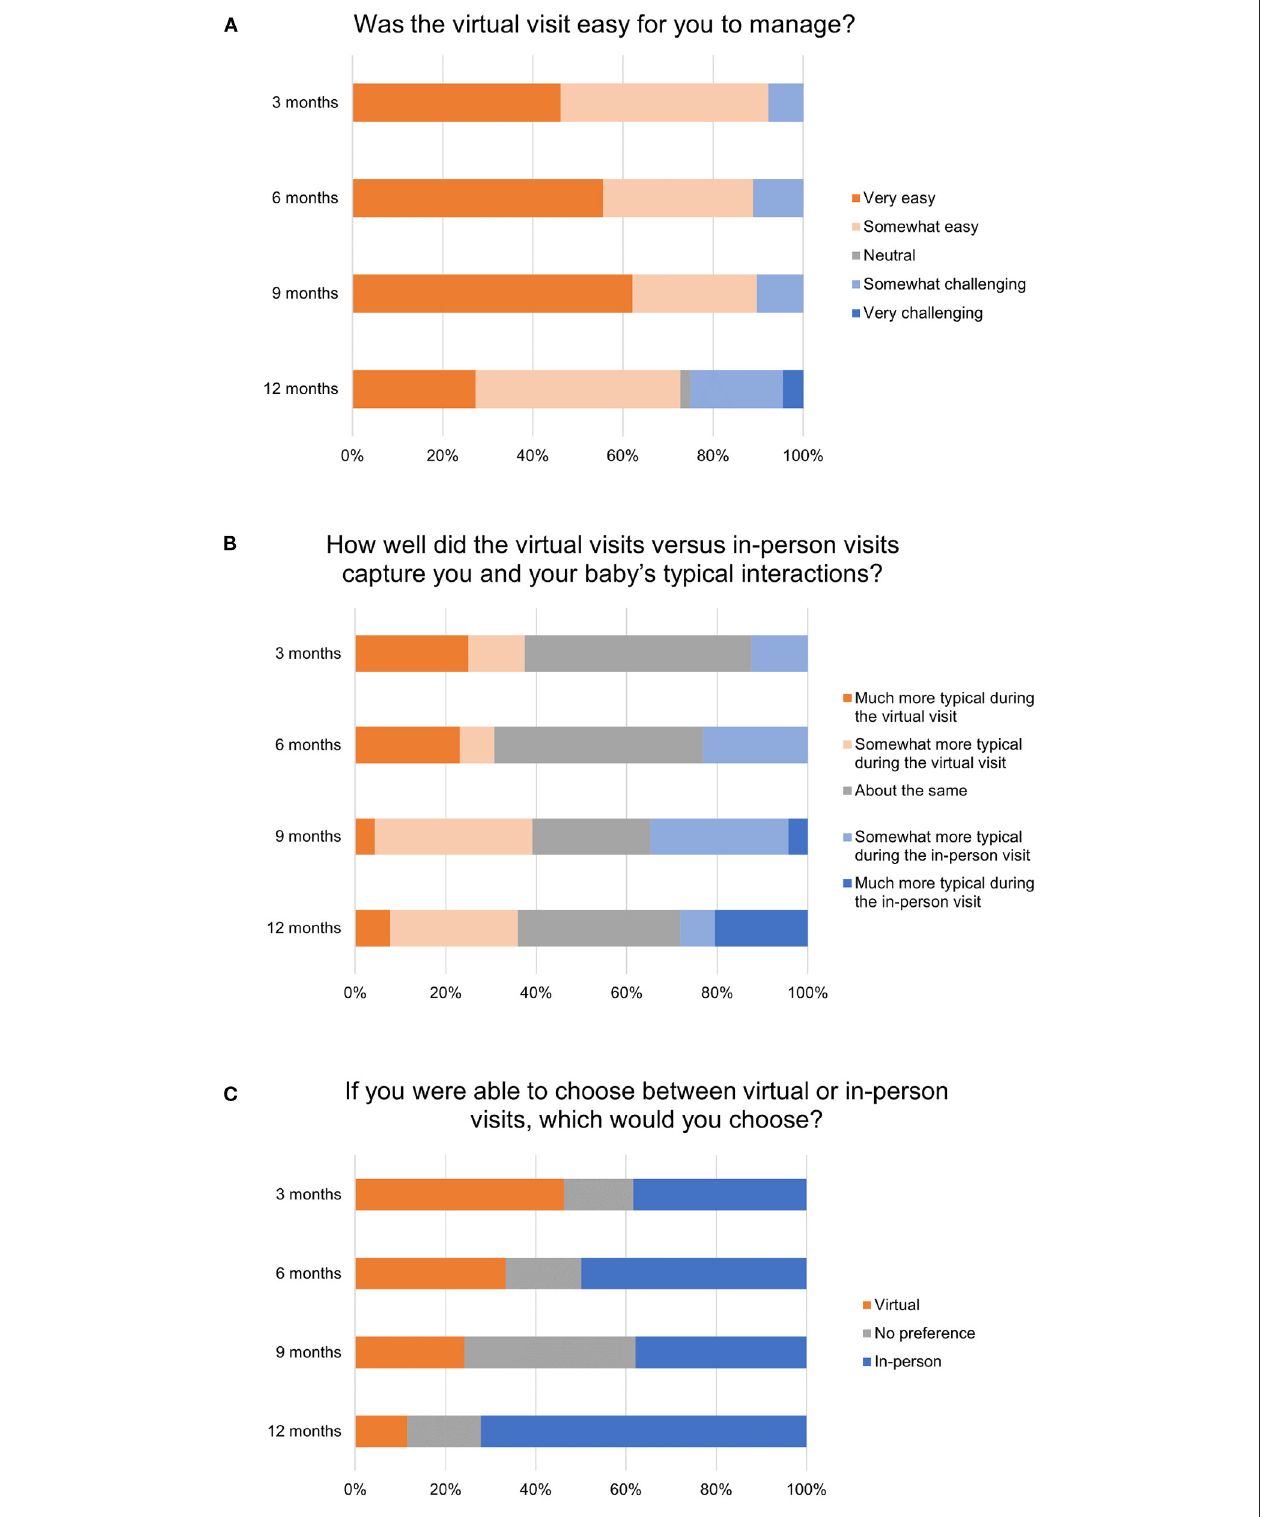
FIGURE 7 | Distributions of mothers’ (A) ratings of ease of virtual visits, (B) ratings of how well the virtual visits captured typical interactions between the mother and her infant, and (C) preferences for virtual versus in-person visits. Exact wording of questionnaire items are shown above. Maternal responses to each item are displayed by time